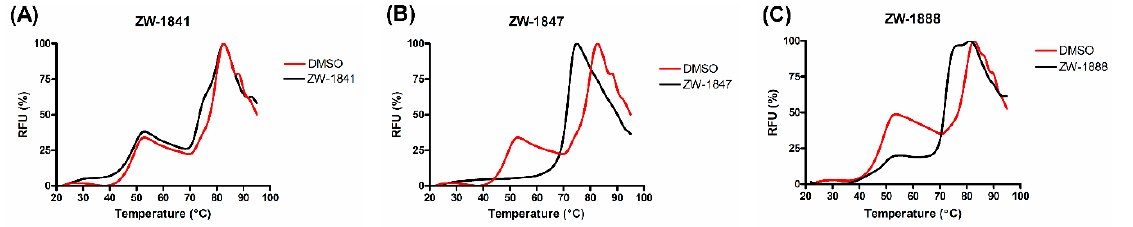
Figure 6. TSA profiles of selected hit compounds that bind to HBV Cp and affect capsid formation and stability. HBV Cp melting curves in the presence of 1% DMSO are shown in red; HBV Cp melting curves in the presence of 20 µ M compound (ZW-1841 ( A ), ZW-1847 ( B ), and ZW-1888 ( C )) and 1% DMSO are shown in